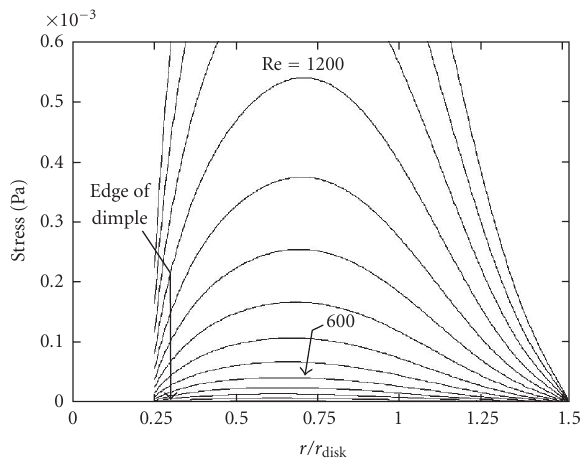
Figure 4: Relationship between fluid shear stress and location at the RDB vessel base. Compuational simulation of shear stresses calcu- lated at the vessel base with respect to distance away from cen- tre axis, expressed as the ratio of base radius ( r ) to the impeller disc radius ( r disk )(Pa = pascal). The term “dimple” represents the small dome-shaped manufacturing artefact observed in the centre all RDB disposable vessels, representing a nonideal boundary.